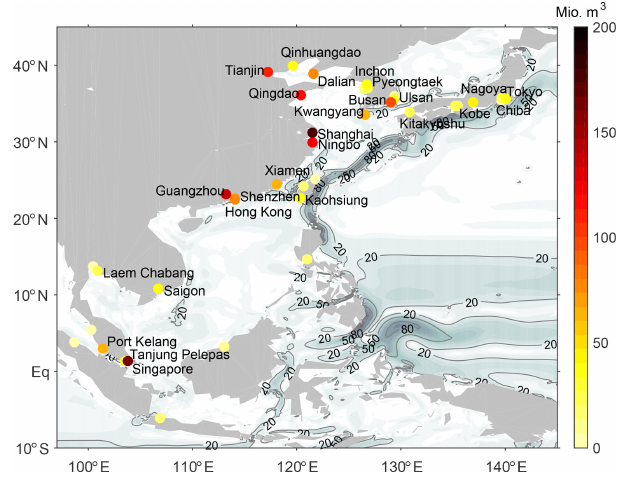
Figure 1. Estimated annual ballast water discharge volume (10 6 m 3 ) from each harbour in the modified world port ranking in Southeast Asia with the names of the 26 largest ports (Supplement table). Contours and black contour lines show climatological ocean surface velocities (cms − 1 ) from